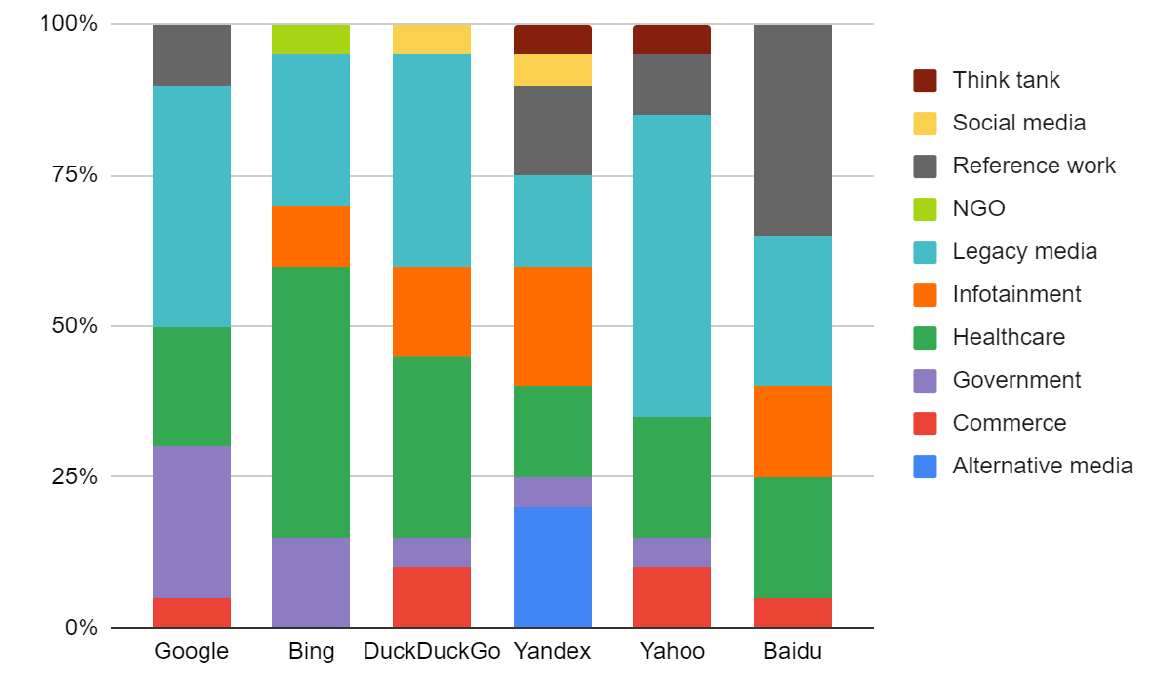
Figure 3. Top 20 results most frequently provided by each engine by category. The y-axis shows the ratio of different categories of sources for each